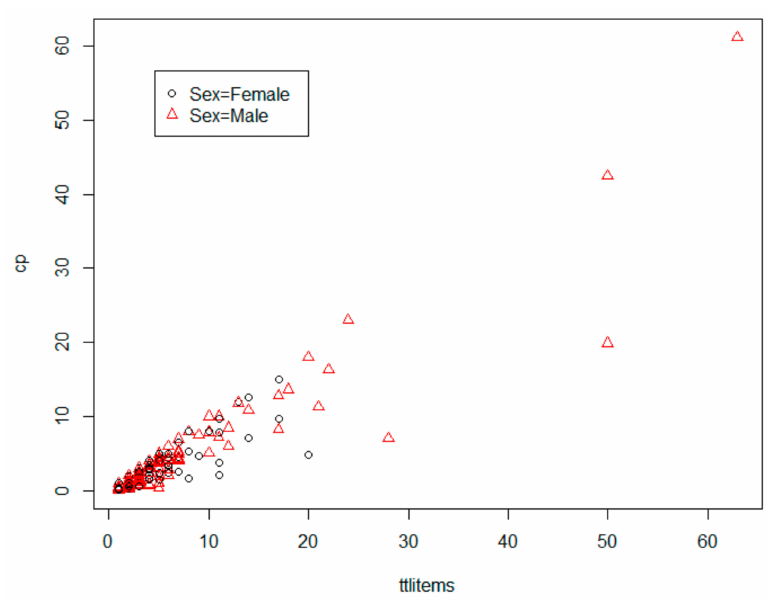
Figure A2. Relationship between nominal productivity and relative productivity by sex.